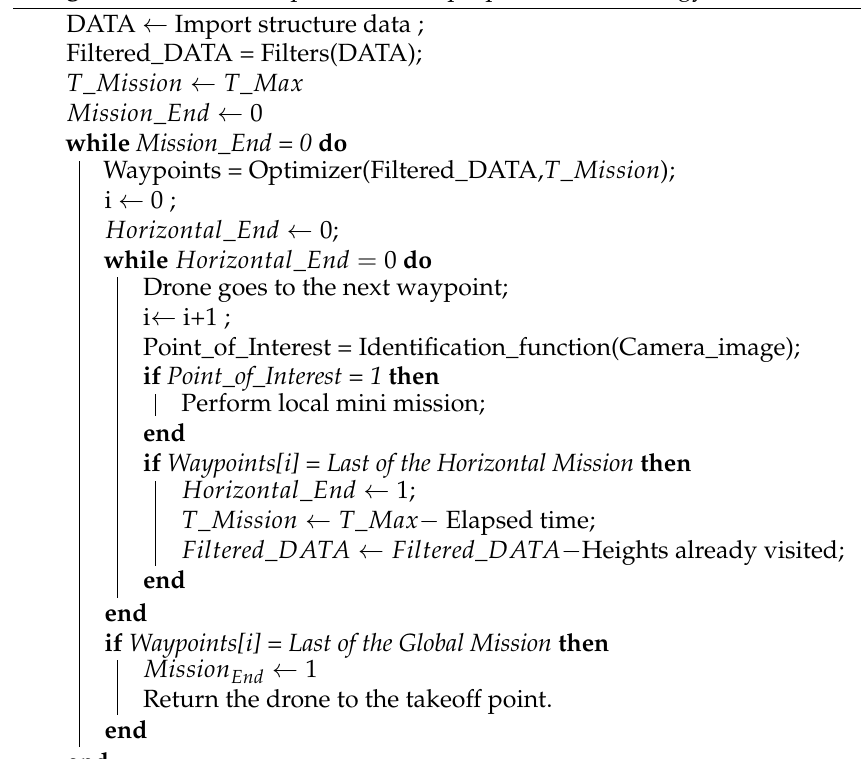
Algorithm 1: Decision process of the proposed methodology.